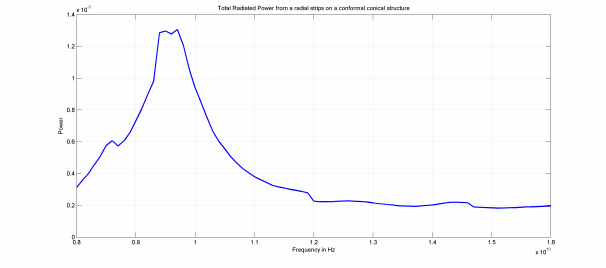
Fig. 11. Total scattered power for plane wave incidence